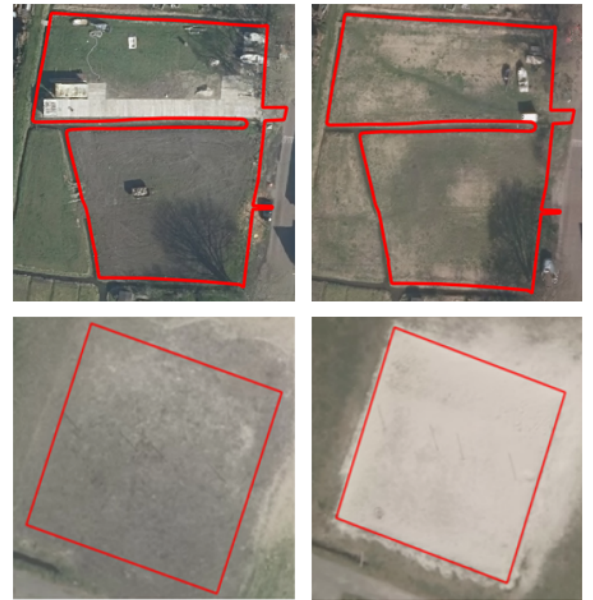
Figure 5. Examples of successful (top) and unsuccessful